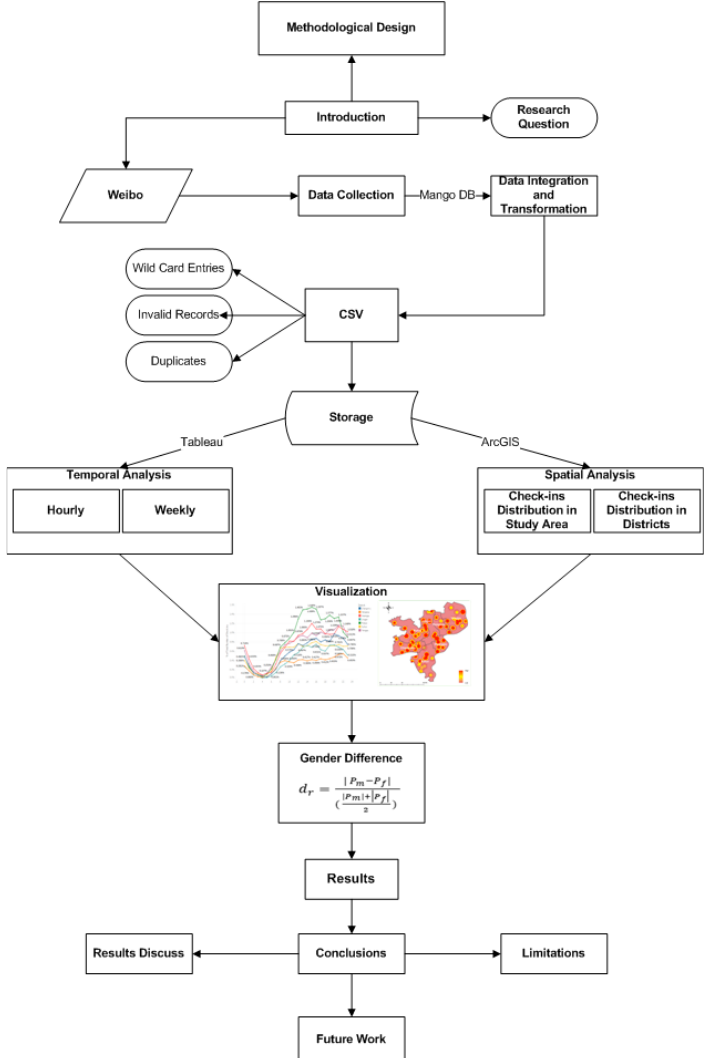
Figure 4. Data processing.